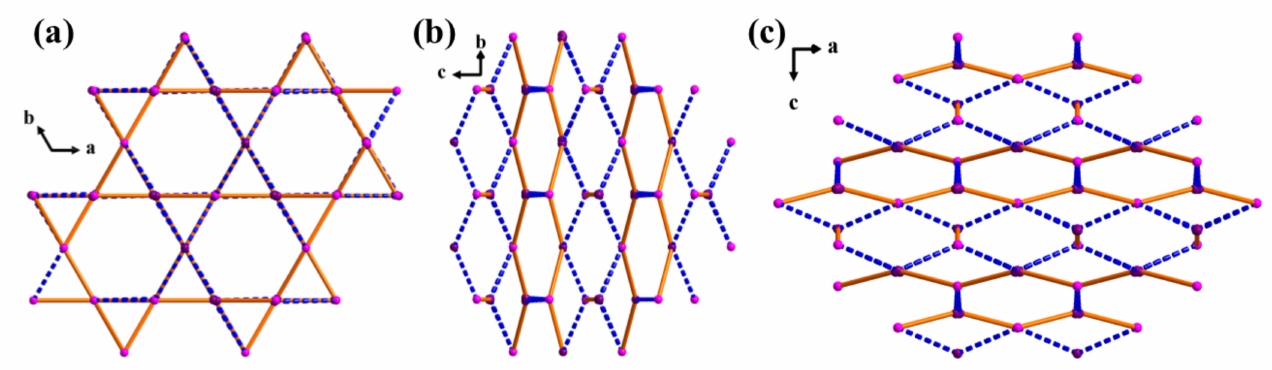
Figure 4. ( a – c ): View of the simplified 3D Co-based hydrogen-bonded framework of 1 from c , a and b directions (violet ball represents the core of bmimb ligand, and pink ball represents Co 2+ ; solid lines represent bmimb ligands, and dash lines represent C–H ··· Cl hydrogen